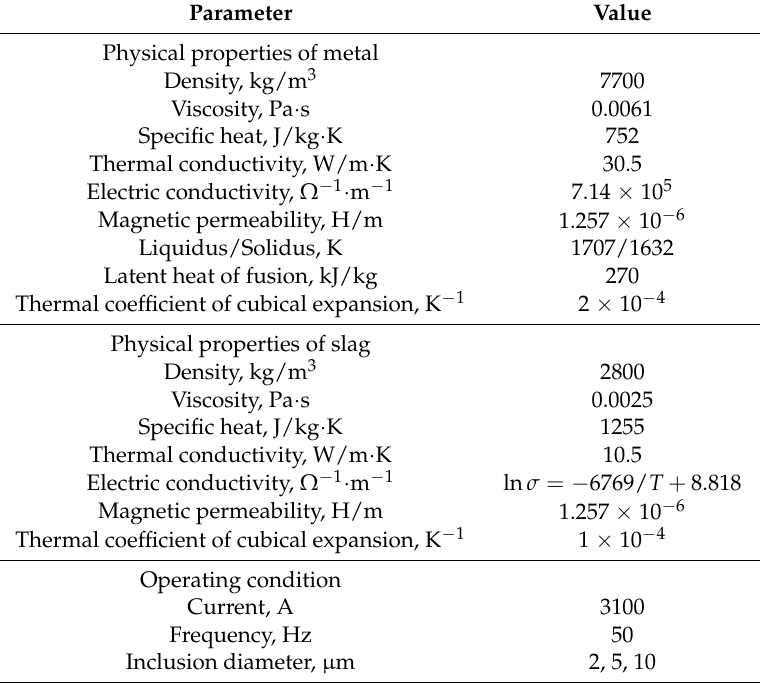
Table 1. Physical properties and operation